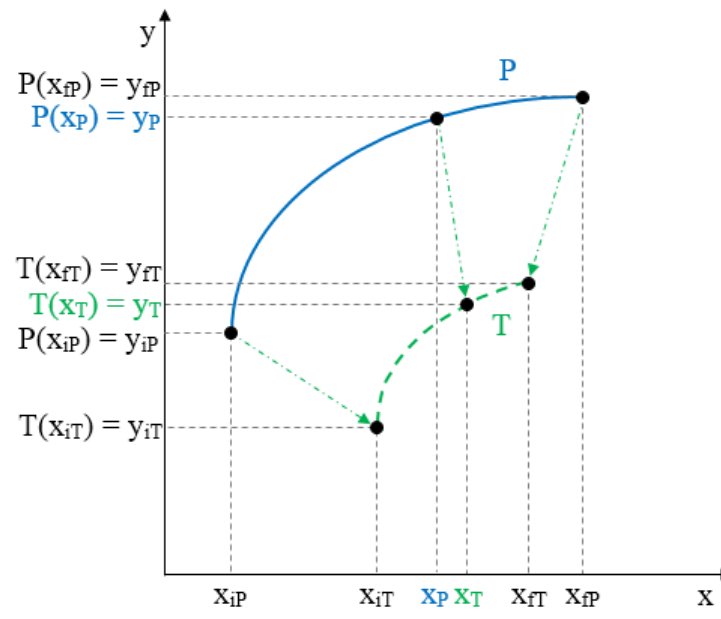
Figure 6. General linear mapping of a pattern curve P into a target curve T